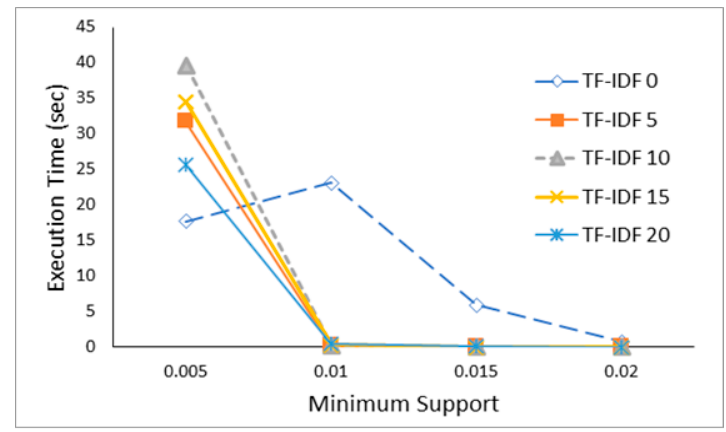
Figure 11. Word Count and Generation Speed according to TF-IDF and Min Support.